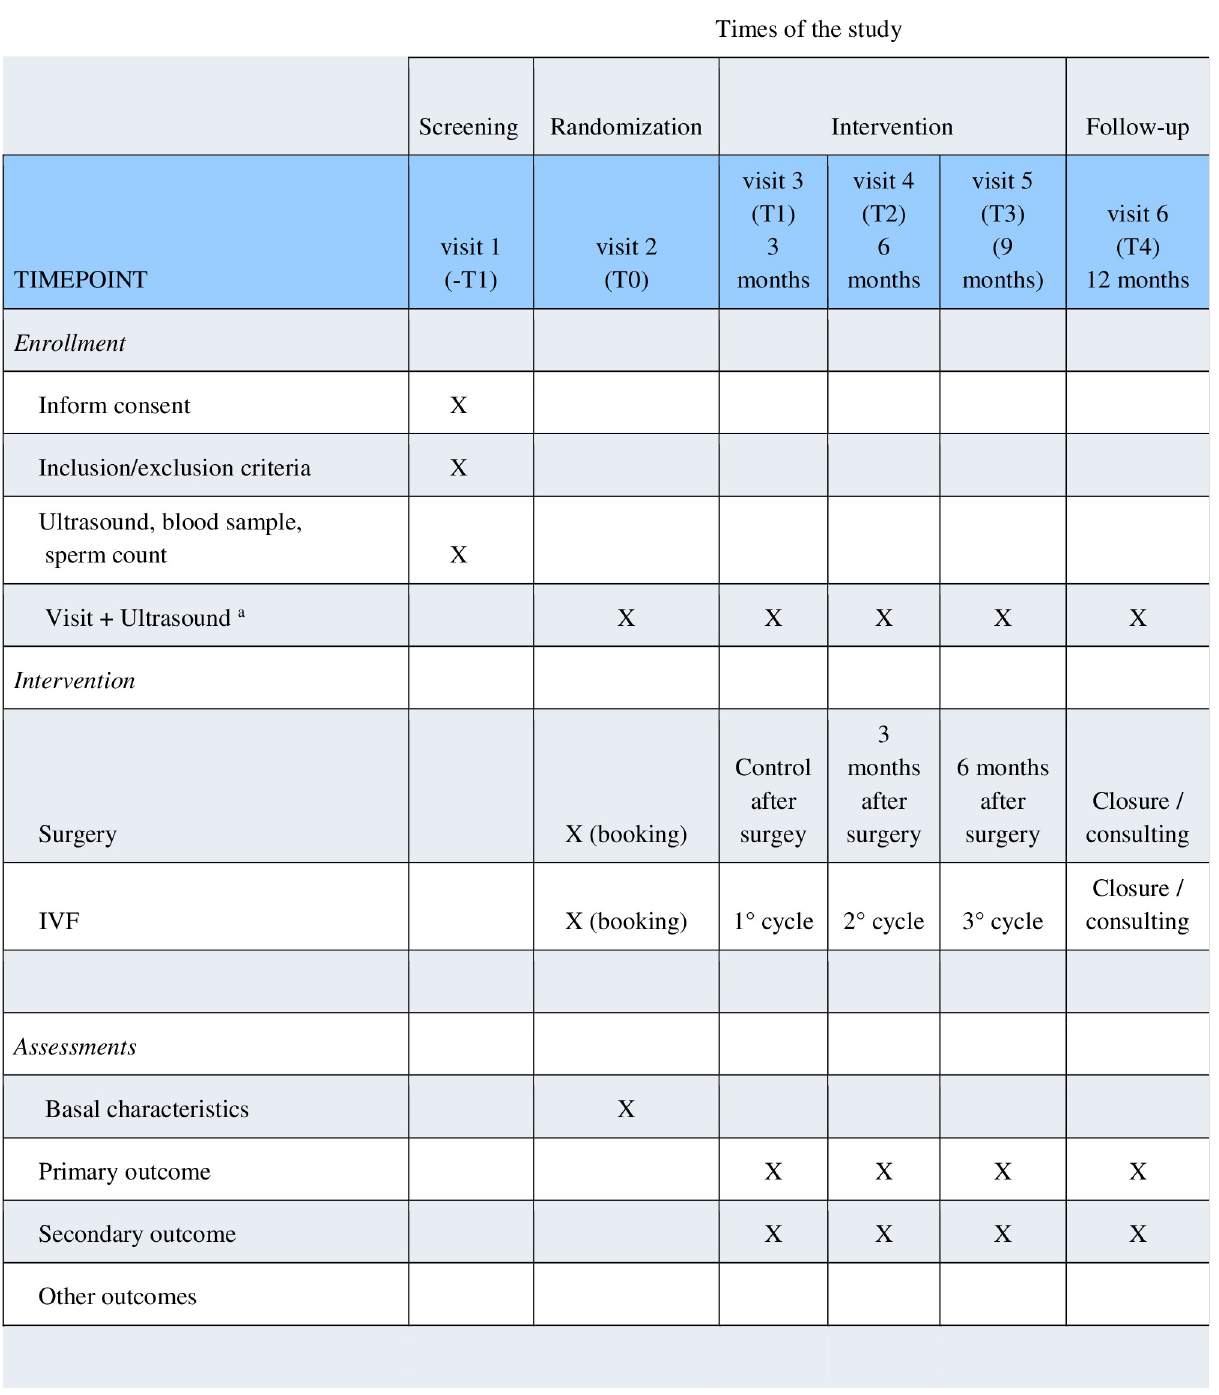
Fig 1. A schedule of enrolment, interventions and assessments of the study protocol.